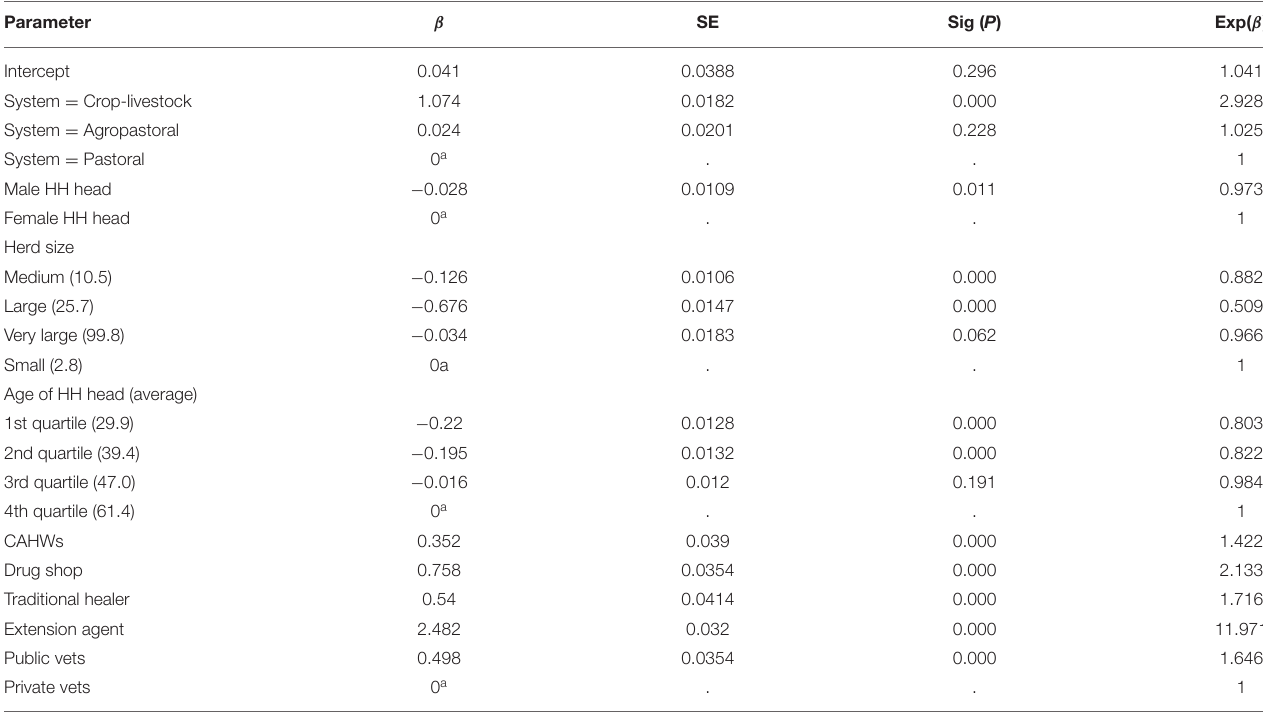
TABLE 7 | The odds of [Exp(B)] a livestock keeper from the different livestock systems, gender and age categories and service providers reporting a higher number of visits in reference to those in the reference category within each parameter. Parameter